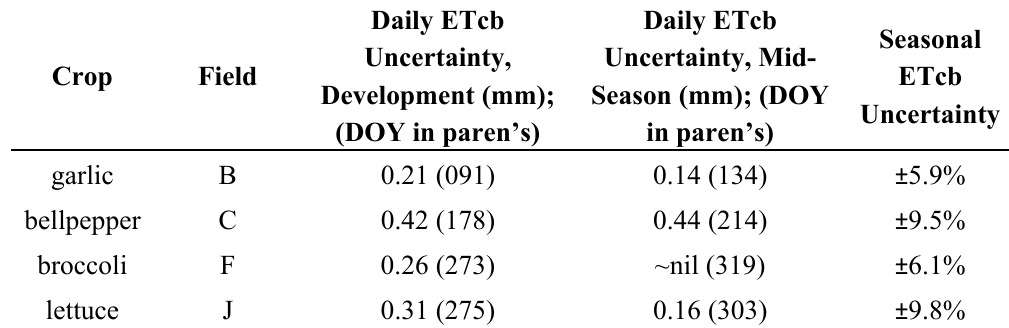
Table 5. ETcb retrieval uncertainties attributable to RMS error of NDVI-Fc Equation (1), for four study fields in 2008. Errors for daily ETcb are shown for DOY corresponding to the development stage with Fc near 50% of the maximum Fc shown on Figure 6, and during mid-season stage at maximum